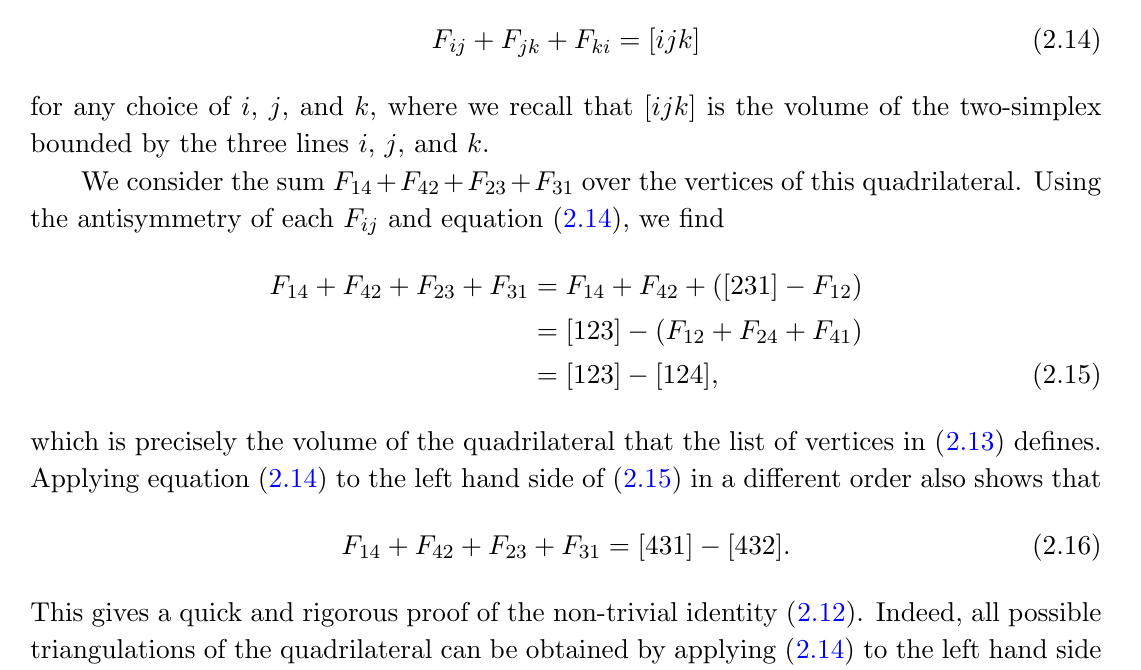
= (cid:0) F , and that they satisfy ij ji